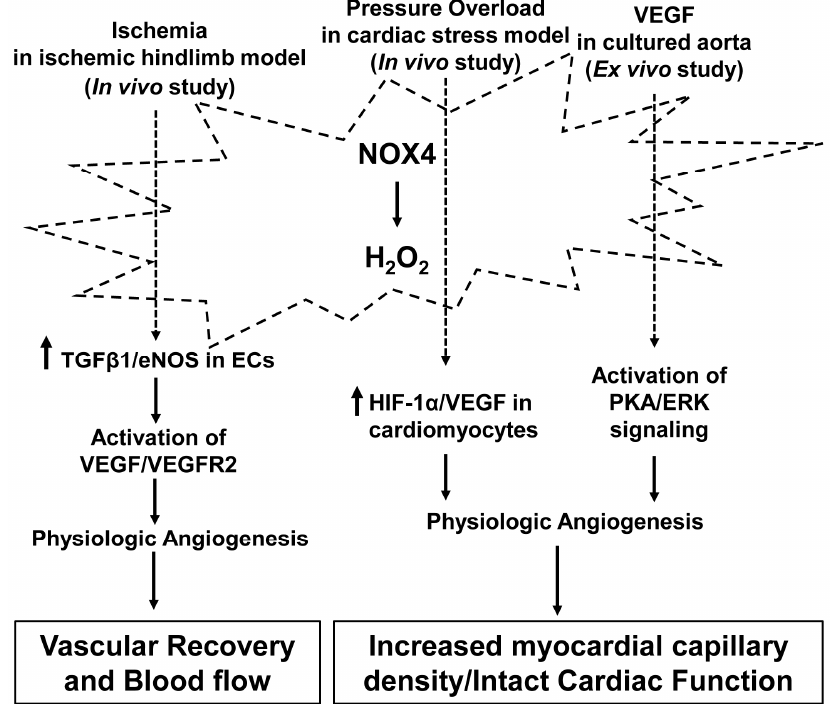
Figure 4. Activation of NADPH oxidase 4 (NOX4) in physiologic angiogenesis. NOX4 is activated by stimuli, including ischemia, pressure overload and VEGF, and generates hydrogen peroxide that mediates physiologic angiogenesis through signaling pathways involved in vascular restoration through revascularization in hindlimb ischemia and cardiac stress, and in ex vivo aortic sprouting. The stimuli designate pathways that have been reported in the literature but do not imply exclusivity. PKA: protein kinase A; ERK: extracellular signal-regulated kinase; VEGFR2: VEGF receptor 2; TGF β 1: transforming growth factor beta1; eNOS: endothelial